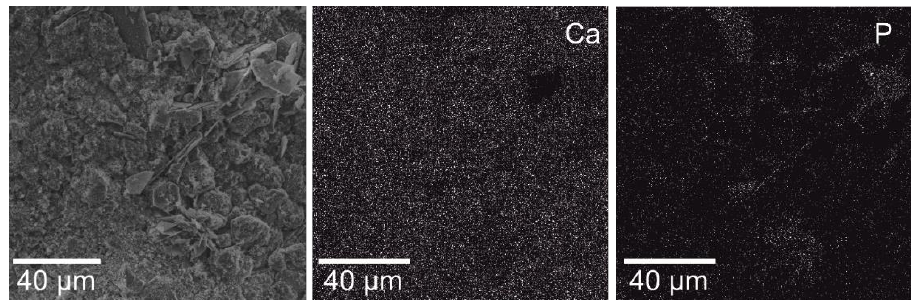
Figure 3. SEM micrographs, EDS mapping of the Ca and P distribution in the electrochemically modified Ti23Zr25Nb alloy in 0.042 M Ca(NO 3 ) 2 + 0.025 M (NH 4 ) 2 HPO 4 + 0.1M HCl bath with the voltage of −10 V and the time of 60 min (B1).